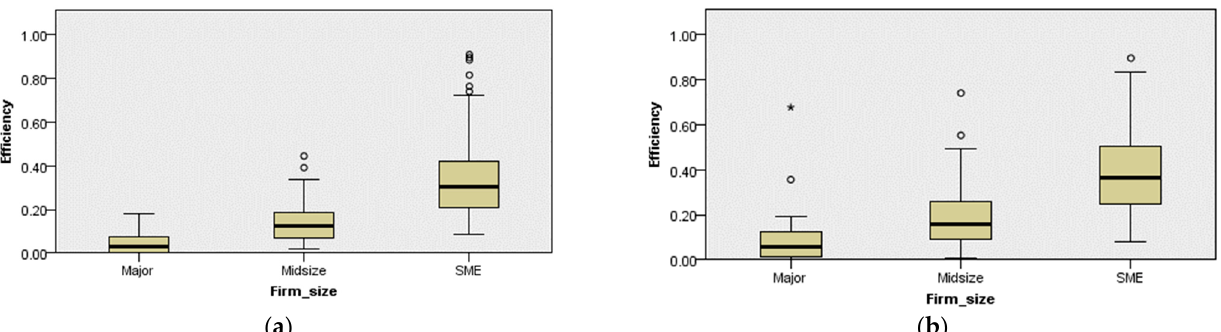
Figure 2. Box plots of profitability efficiency by firm size in the ICT manufacturing ( a ) and service industries ( b ).